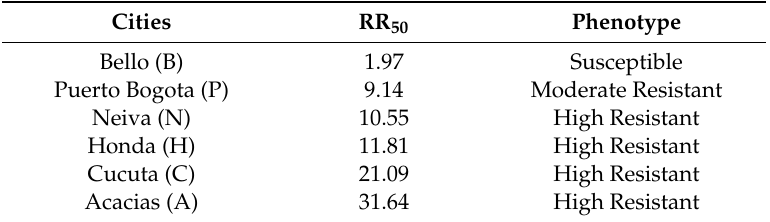
Table 1. Insecticide phenotypic profile (resistance ratio: RR) of Aedes aegypti populations collected in six Colombian cities against lambda-cyhalothrin.